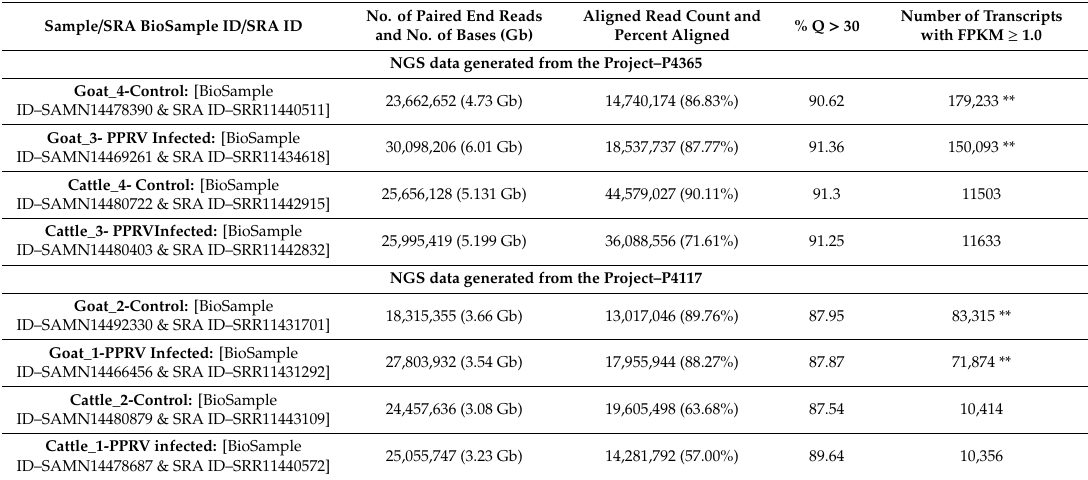
Figure 1. The bioinformatic workflow for analysis of the generated reads to determine the differentially expressed transcripts in peripheral blood mononuclear cells (PBMC) of goat and cattle upon infection with Peste des petits ruminants virus (PPRV). Table 2. The quantity and quality of the data generated in the next generation sequencing